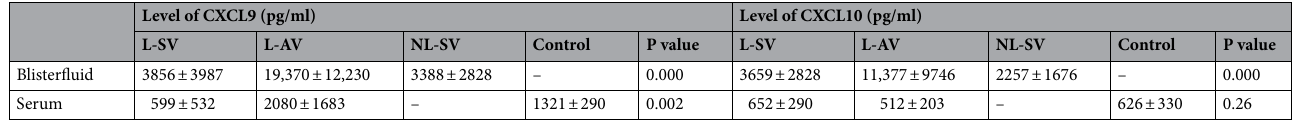
Table 2. The mean values of blister fluid and serum CXCL9/CXCL10 levels in vitiligo patients and controls.